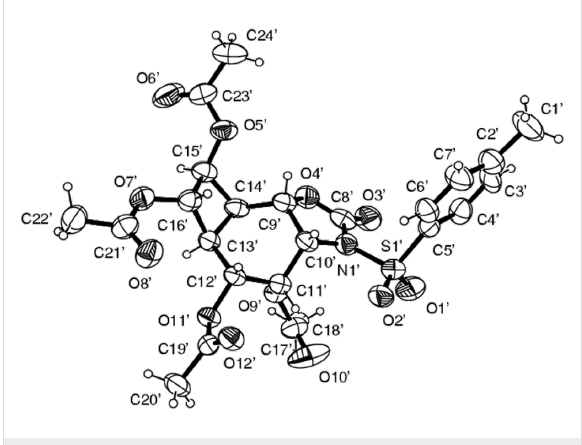
Figure 1: The thermal ellipsoid plot of the single crystal X-ray crystallo- graphic structure of 18 .